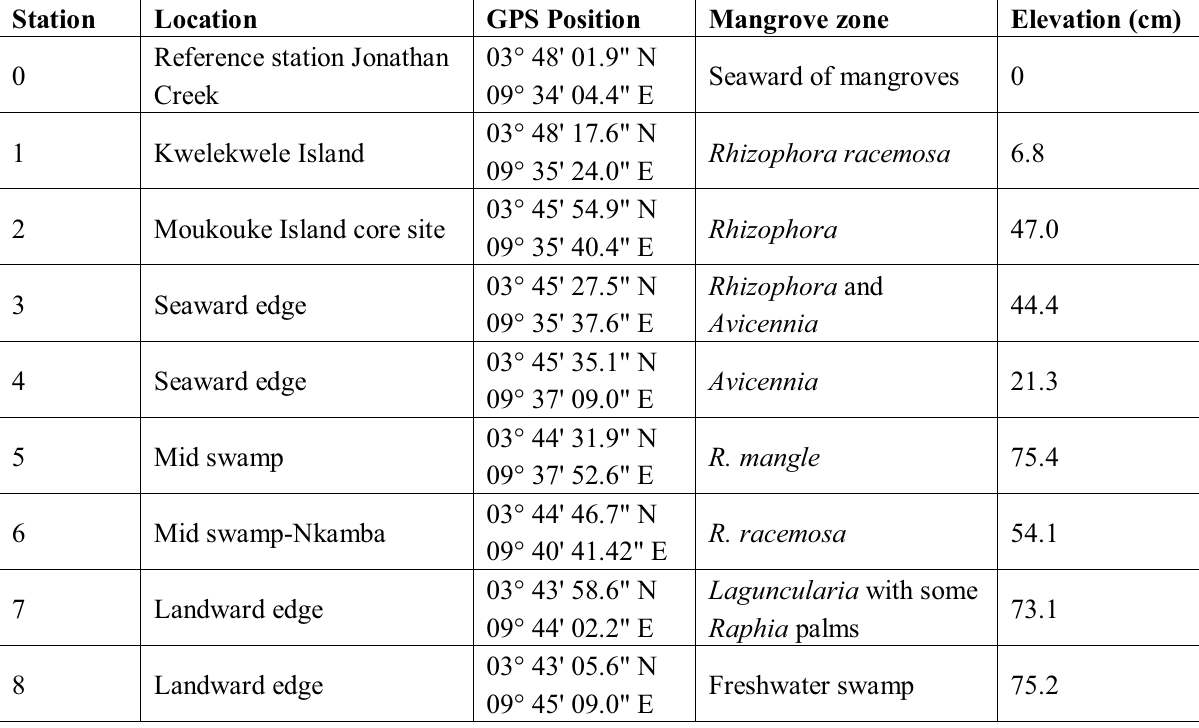
Table 5. Relative elevation of mangrove substrate surface of the Doula-Edea mangrove